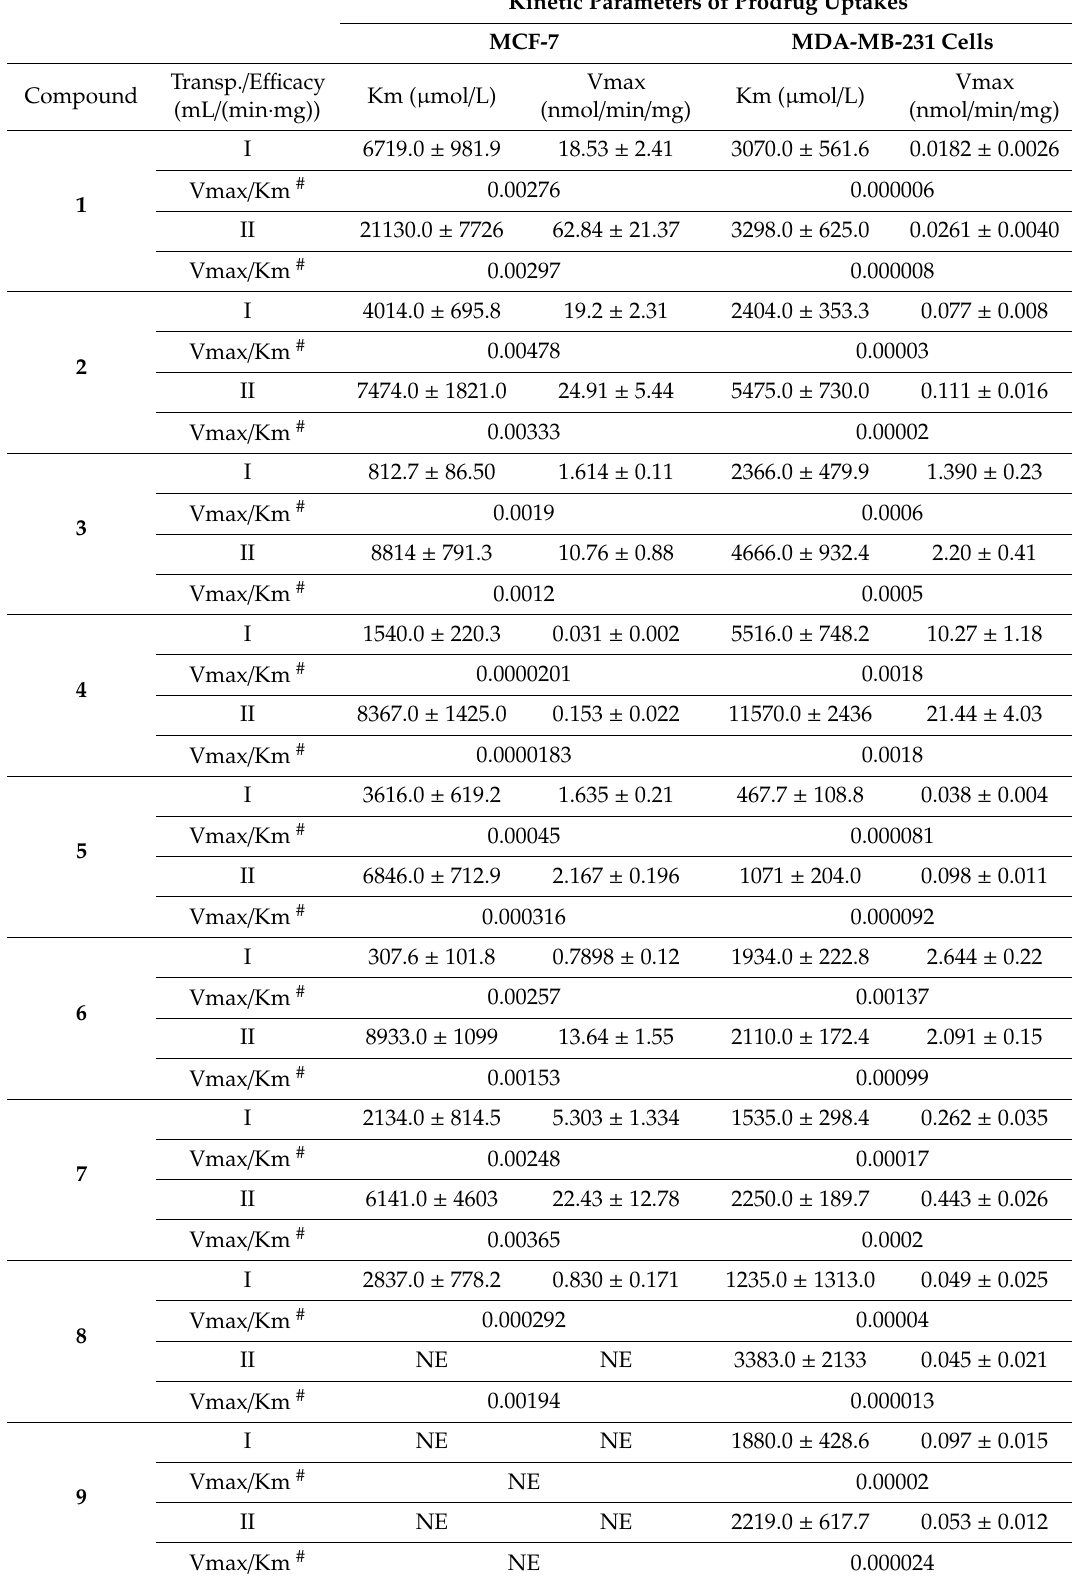
Table 2. Eadie-Hofstee analysis of the uptake of sulfonamide derivatives of metformin in MCF-7 and MDA-MB-231 cells (Km and Vmax